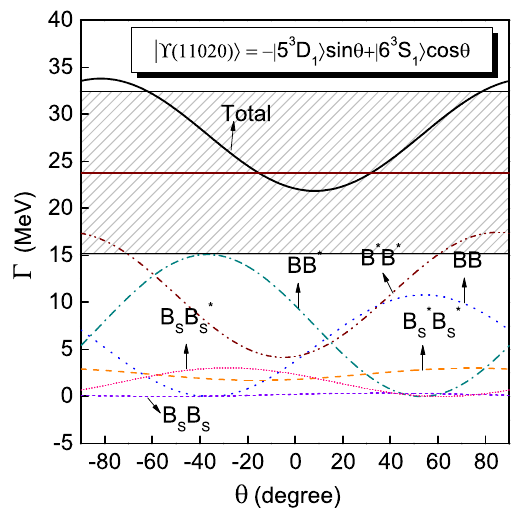
Fig. 3 Strong decay of ϒ( 11020 ) versus the mixing angle θ within screened potential model.The horizontal line is the center value of the experiment, and the shaded region represents the error range of the experiment